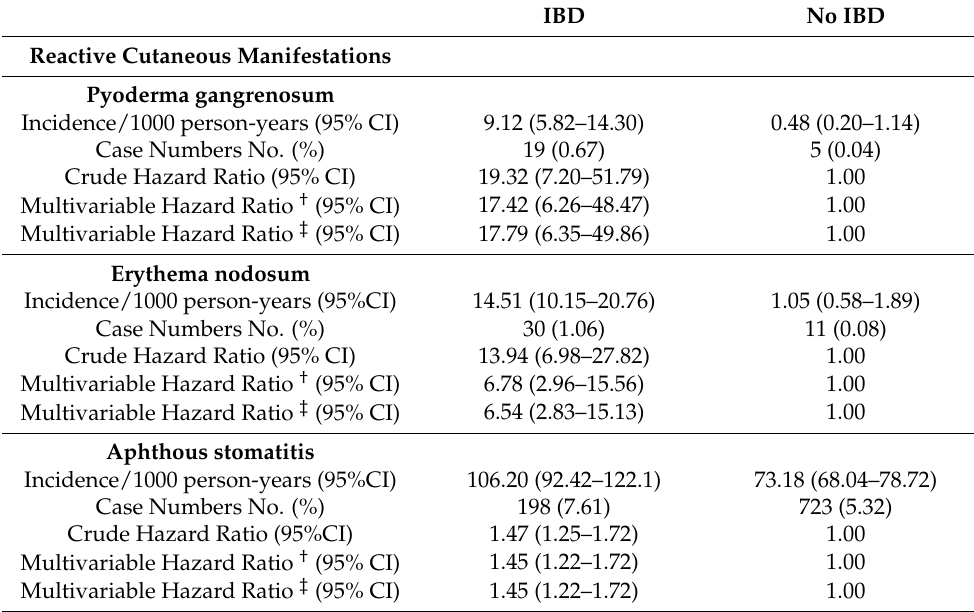
Table 3. Incidence and hazard ratio for dermatologic disease after diagnosis of